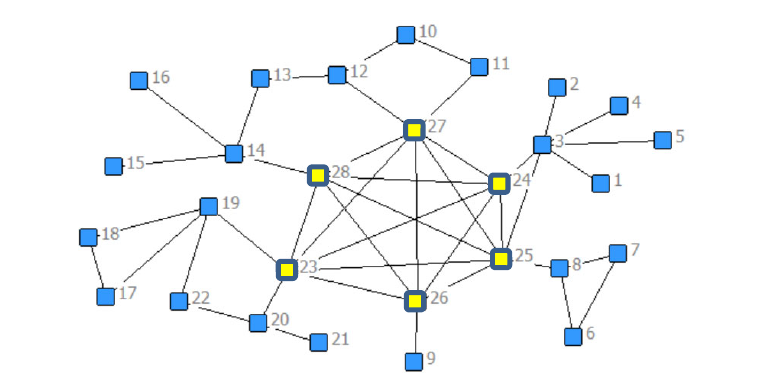
Figure 2. The network without